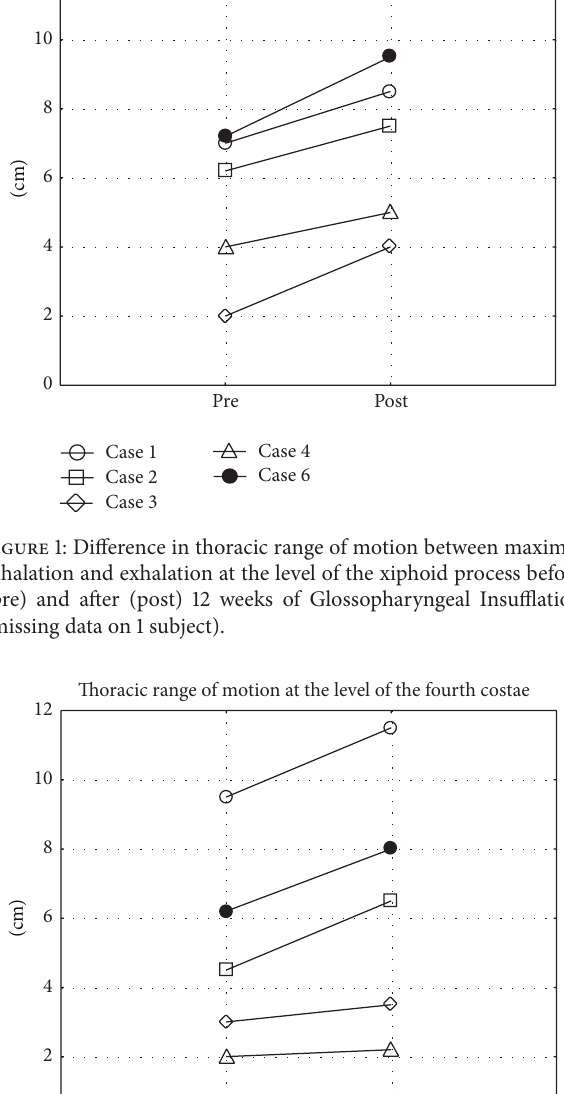
Table 1: Baseline characteristics of the 6 subjects fulfilling the study protocol.